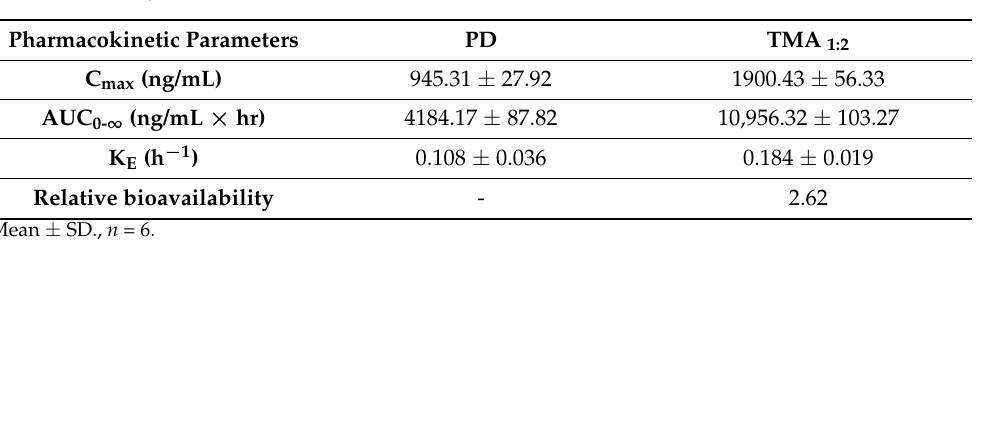
Table 2. Comparative pharmacokinetic data of pure telmisartan (PD) and optimized telmisartan-maleic acid cocrystal (TMA 1:2 ).